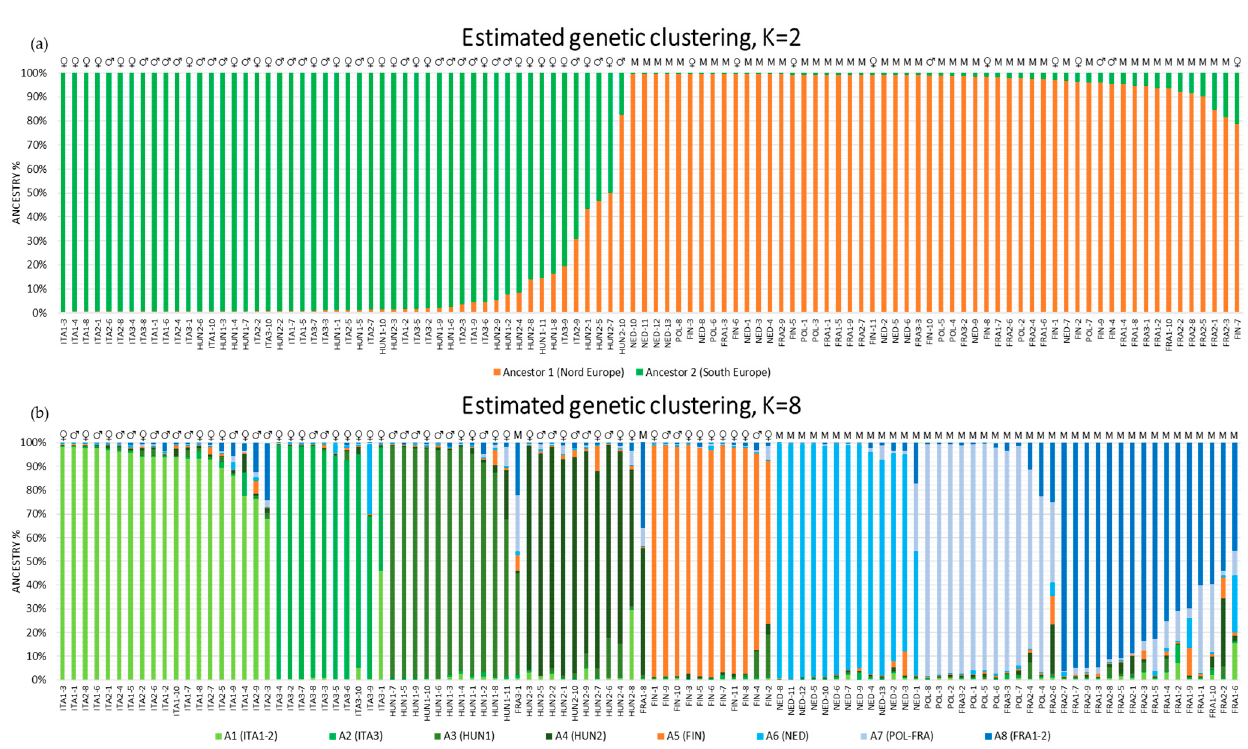
Figure 1. Population structure with K = 2 ( a ) and K = 8 ( b ) of the 104 Cannabis accessions based on the 20 selected SSR marker loci. Symbols: ♀ : dioecious female sample, ♂ : dioecious male sample; M: monoecious sample.